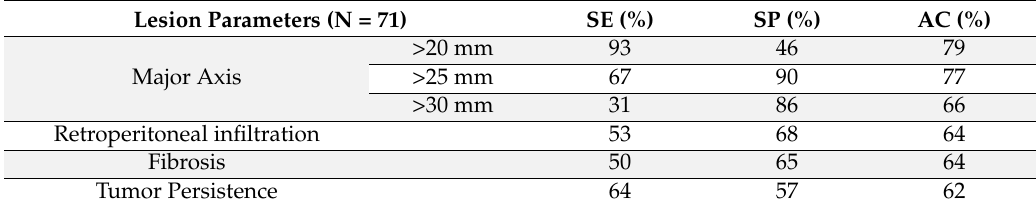
Figure 1. CT images of PDAC (pancreatic phase). At the CT evaluation; the lesion before chemoradiotherapy (left) is quite similar to the post-chemoradiotherapy evaluation (right), showing only minimal dimensional regression. No tumor persistence was reported in the resection specimen. Table 3. Sensitivity, specificity, and accuracy values reported for imaging parameters referring to the respective anatomopathological finding. AC = Accuracy. SE = Sensitivity. SP = Specificity. Lesion Parameters (N =